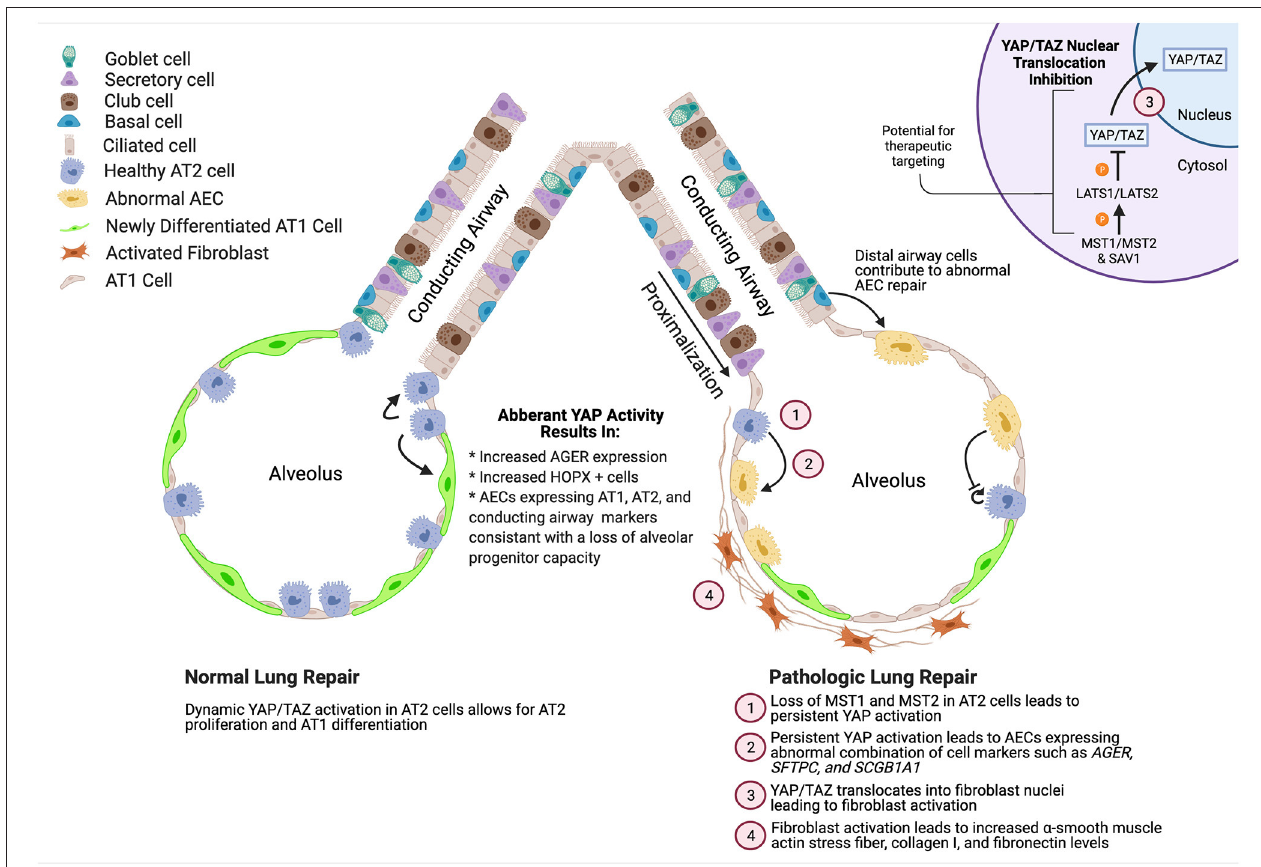
FIGURE 1 | Summary of role of YAP activity during normal and pathologic alveolar repair. YAP/TAZ activation during normal development enhances AT2 cell proliferation and promotes AT1 cell differentiation while deletion of YAP/TAZ leads to increased expression of mature AT2 cell markers. During repair, YAP/TAZ is